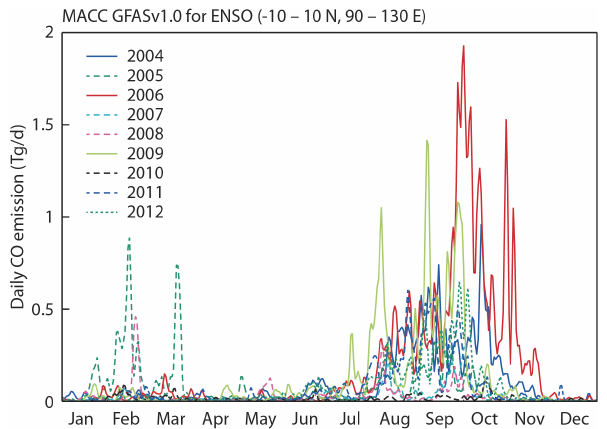
Figure 4. Time series of daily CO emissions in Tg (10 12 g) per day from GFAS v1.0 for the region 10 ◦ N–10 ◦ S, 90–130 ◦ E for the years 2003 to 2012.